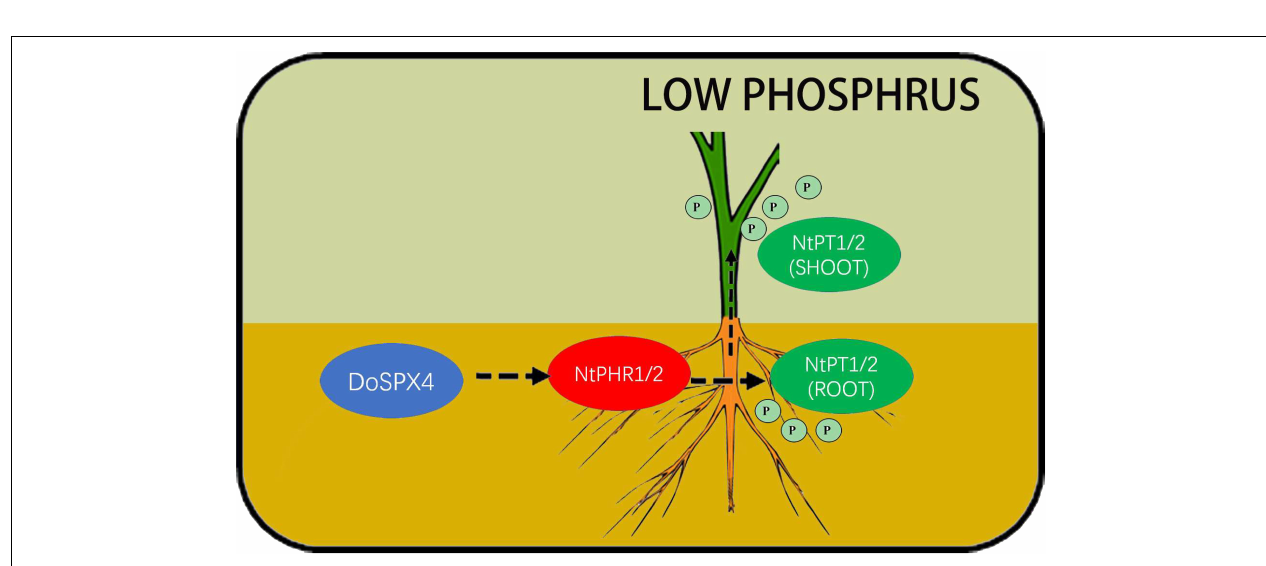
FIGURE 9 | Possible DoSPX4 impact mechanism. DoSPX4 promoted the expression of NtPHR1/2 in roots, induced the expression of NtPT1/2 and high-affinity phosphate transporter in roots and shoot, and promoted the transportation of Pi from roots to stems in transgenic N. tabacum in low phosphorus.